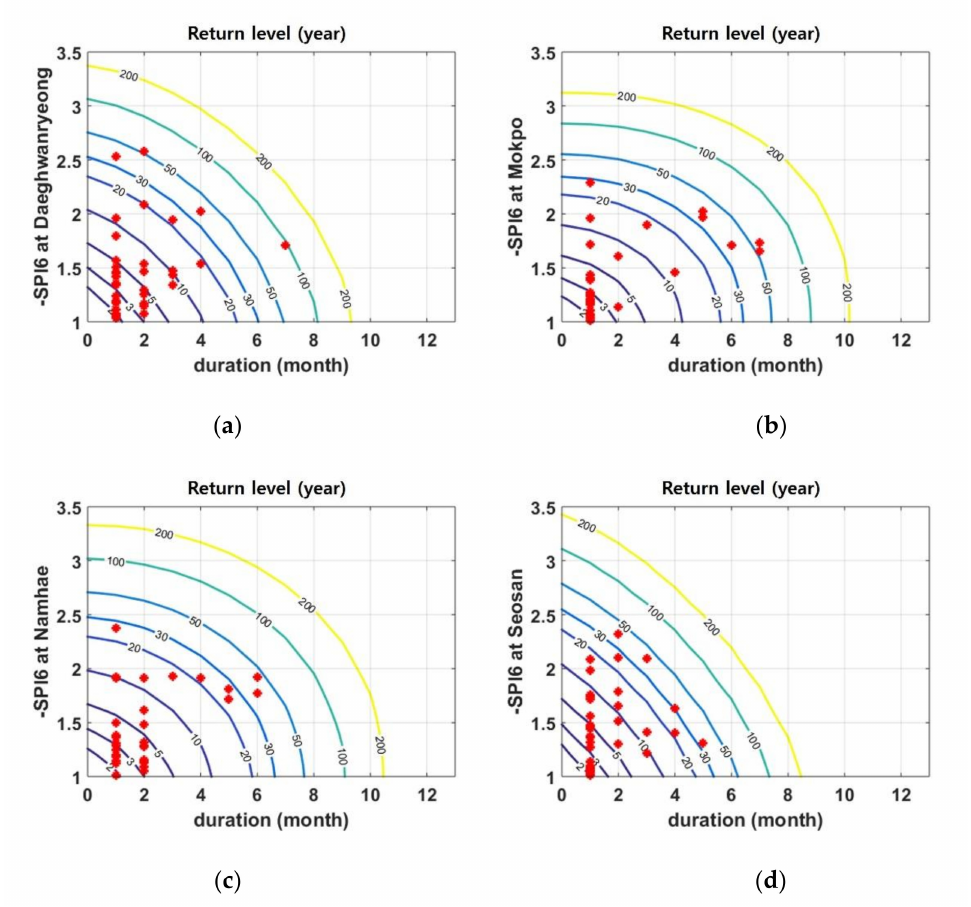
Figure 6. SDF curves using bivariate exponential distribution at ( a ) Daeghwanryeong, ( b ) Mokpo, ( c ) Namhae, and ( d ) Seosan. In Figure 6, * indicates the drought severity and duration of the observed drought